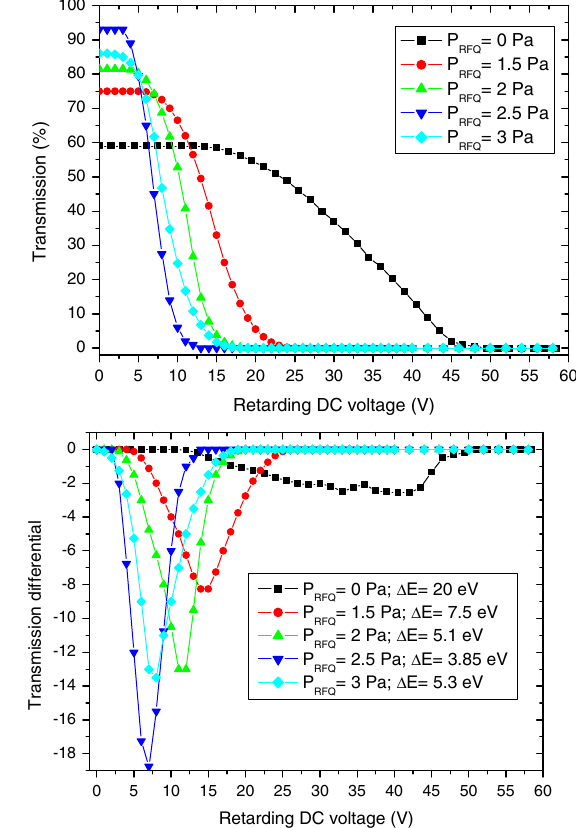
FIG. 11. Measurements of the longitudinal energy spread with various buffer gas pressure P and for beam current of 50 nA: RFQ variation of the transmission as a function of the retarding dc voltage (top) and variation of its differential versus the retarding dc voltage